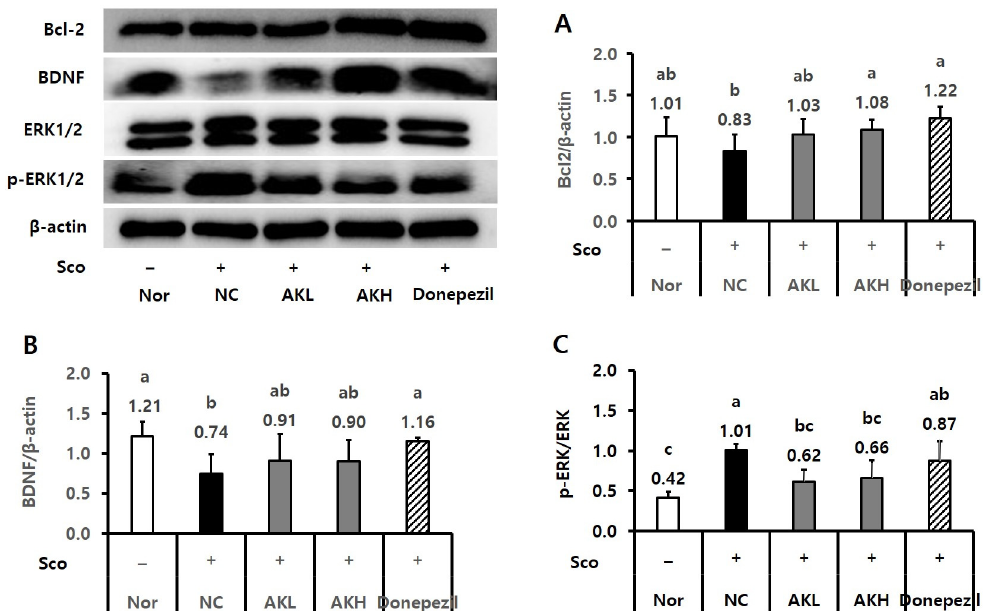
Figure 6. Effects of AK extract on the expression of hippocampal ( A ) Bcl2, ( B ) BDNF, and ( C ) p-ERK1/2/ERK in chronically scopolamine-treated rats. The rats were randomly divided into five groups: Nor: normal, commercial diet + saline; NC: negative control, commercial diet + scopolamine in saline; AKL: commercial diet of AK extract 0.14% + scopolamine in saline; AKH: commercial diet of AK extract 0.42% + scopolamine in saline; Do: commercial diet + Donepezil 1 mg/kg in saline + scopolamine in saline ( n = 6 for Bcl2, n = 5 for BDNF and n = 4 for p-ERK/ERK). All rats, except those in the normal group, were intraperitoneally administered scopolamine (1 mg/kg/day) for 21 days. Food and water were freely accessible. Statistical analysis was performed using SAS software. The values indicated with different letters were observed to differ significantly at p < 0.05 by Duncan’s multiple range test.